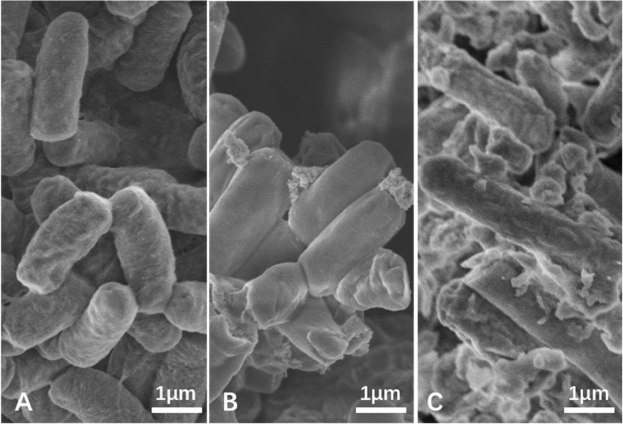
Figure 2. SEM images of Bacillus sp. MRP-3 under Pb and Cr stress (( A ): control group, ( B ): 1 mmol · L − 1 Pb, ( C ): 1 mmol · L − 1